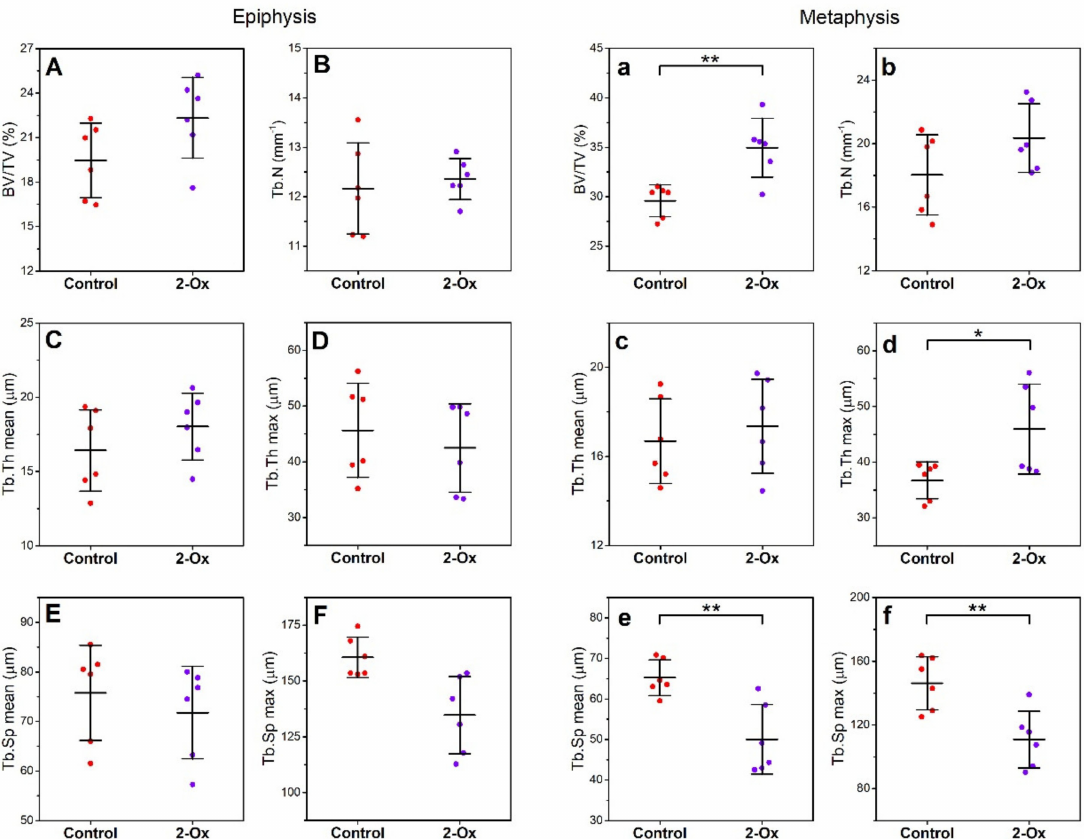
Figure 5. The e ff ect of dietary supplementation with 2-Ox on the histomorphometry of femoral trabeculae in bone epiphysis ( A – F ) and metaphysis ( a – f ) in glucocorticoid-induced, growth-retarded, mature gilts. BV / TV—relative bone volume; Tb.N—trabecular number; Tb.Th—trabecular thickness; Tb.Sp—trabecular